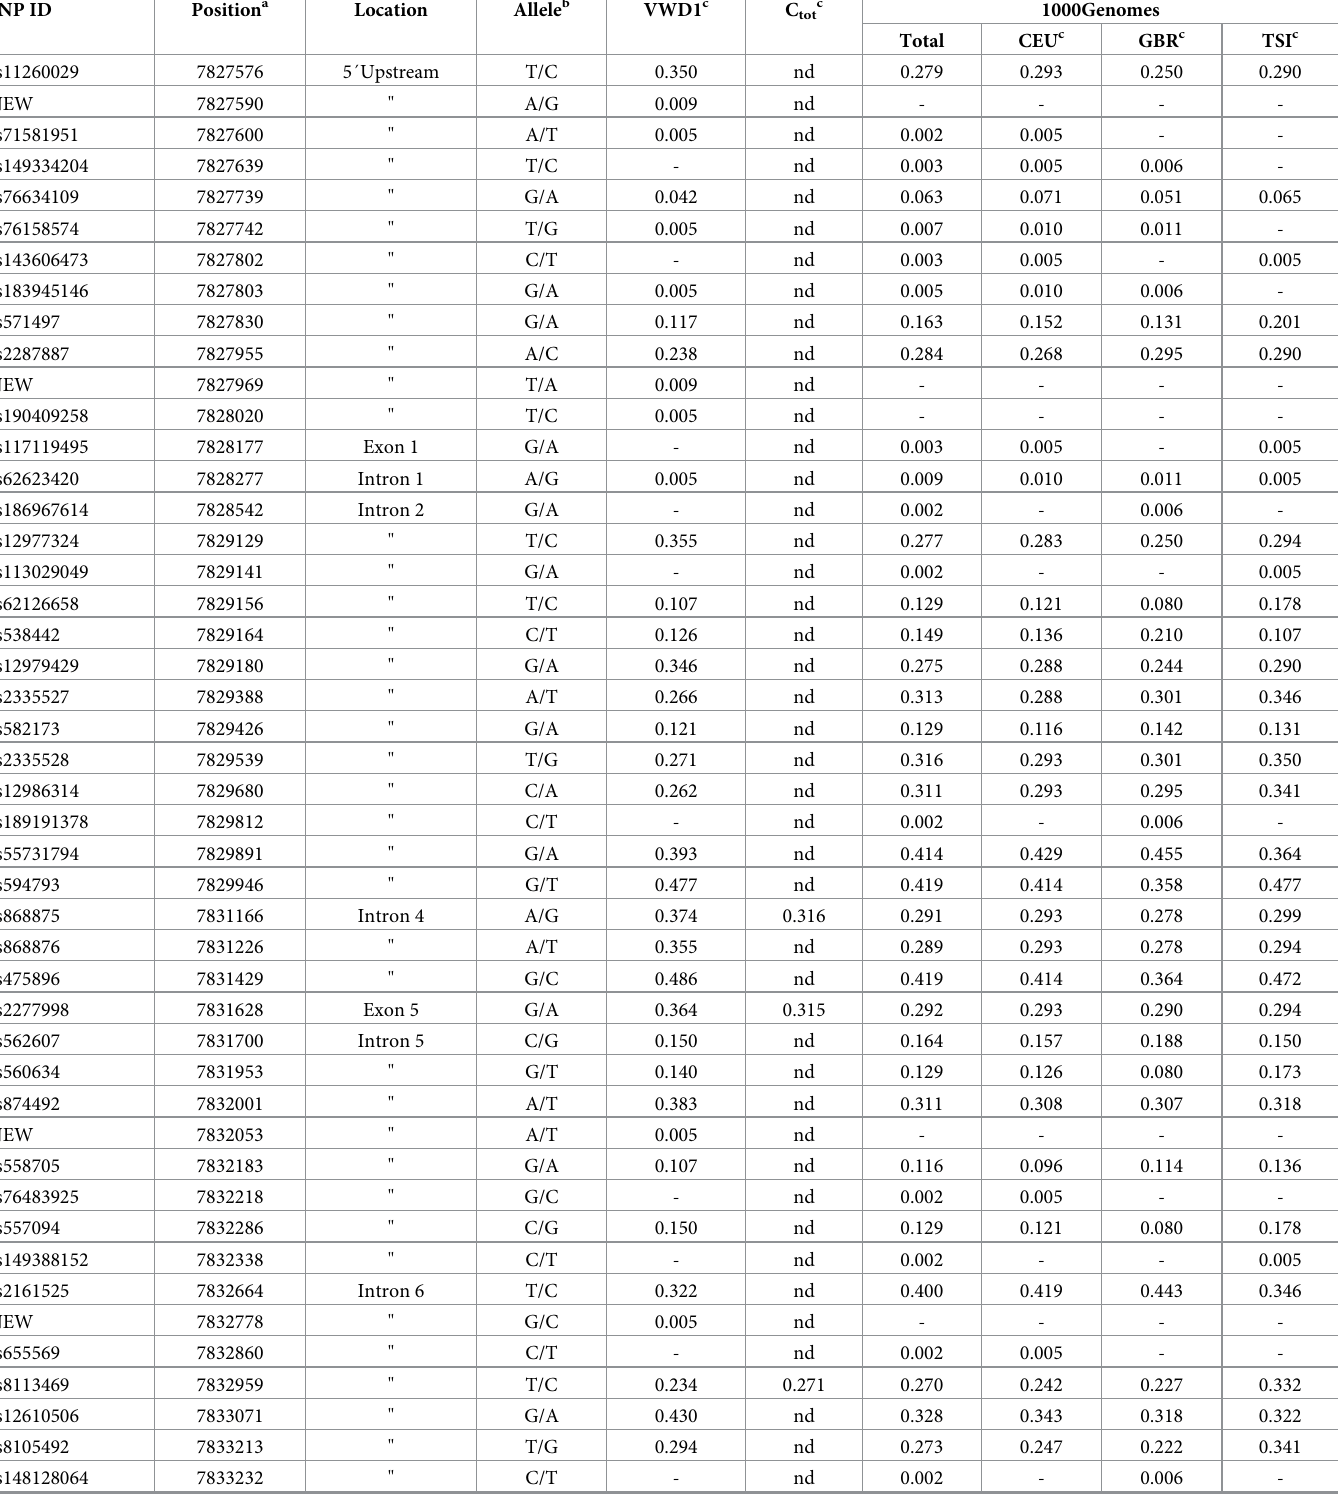
Table 2. CLEC4M variants in Swedish type 1 VWD patients (n = 106) and controls (n = 436) and in three 1000Genomes populations (n =